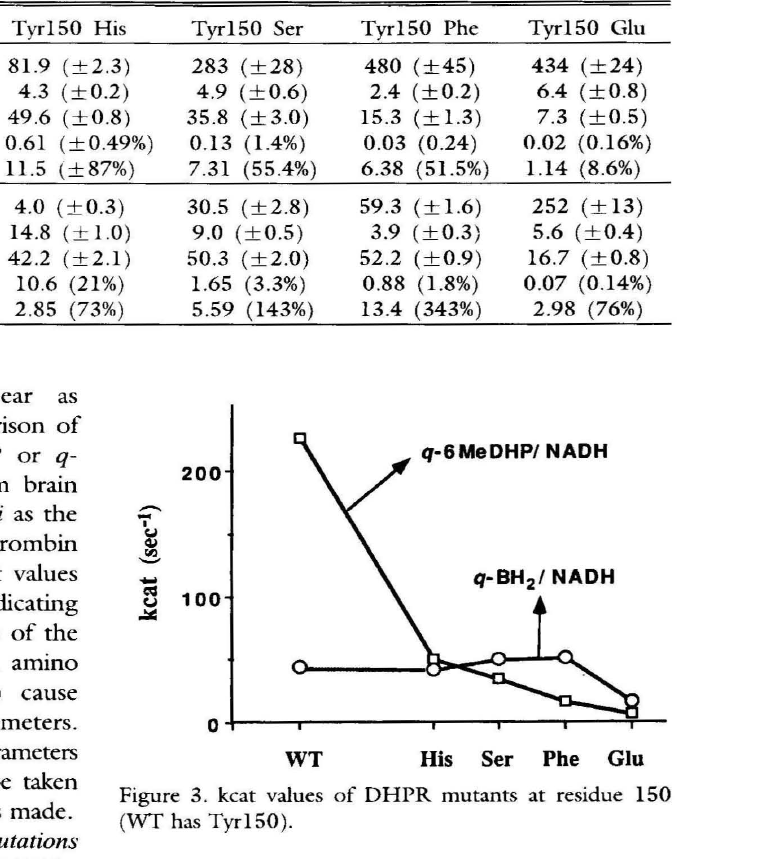
Figure 3. kcat values of DHPR mutants at residue 150 (WT has